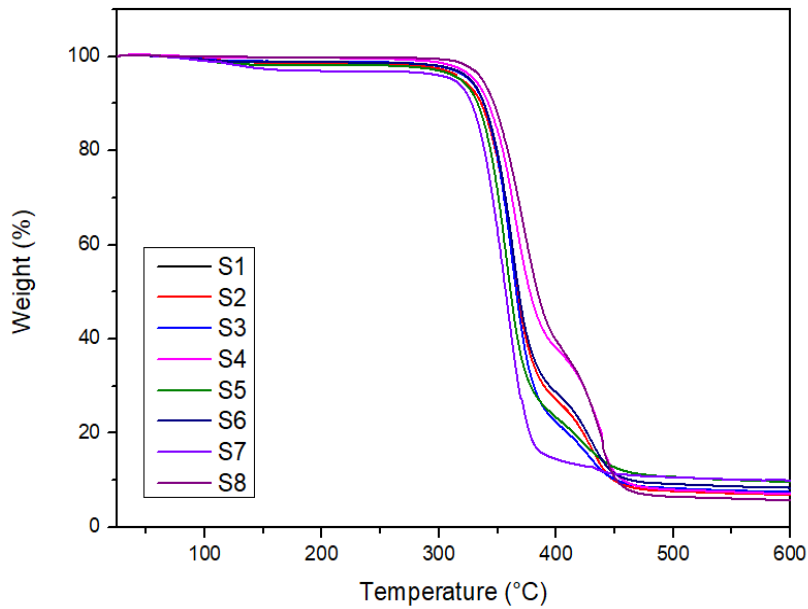
Figure 2. TG thermogram of laminated composites.